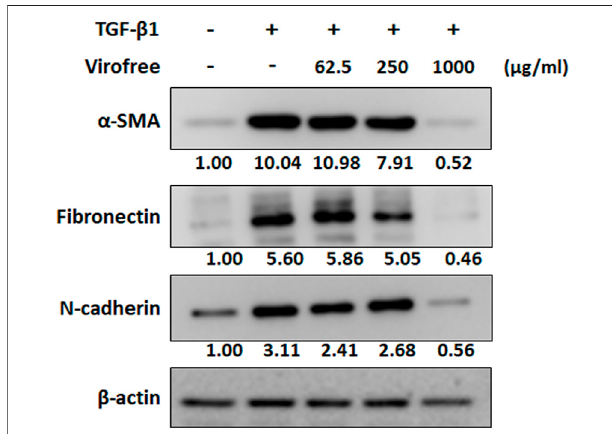
FIGURE 6 | Virofree inhibits TGF- β 1-induced α -SMA and ECM protein expression. LL29 cells were co-treated with 2.5 ng/ml TGF- β 1 and Virofree at different concentrations for 48 h. Quanti fi cation showed a suppressive effect of Virofree on the expression of α -SMA, fi bronectin, and N-cadherin expressionviaWesternblotanalysis( n=3 ).Alldataarepresentedasmeans± SD. * p < 0.05, ** p < 0.01, and *** p <